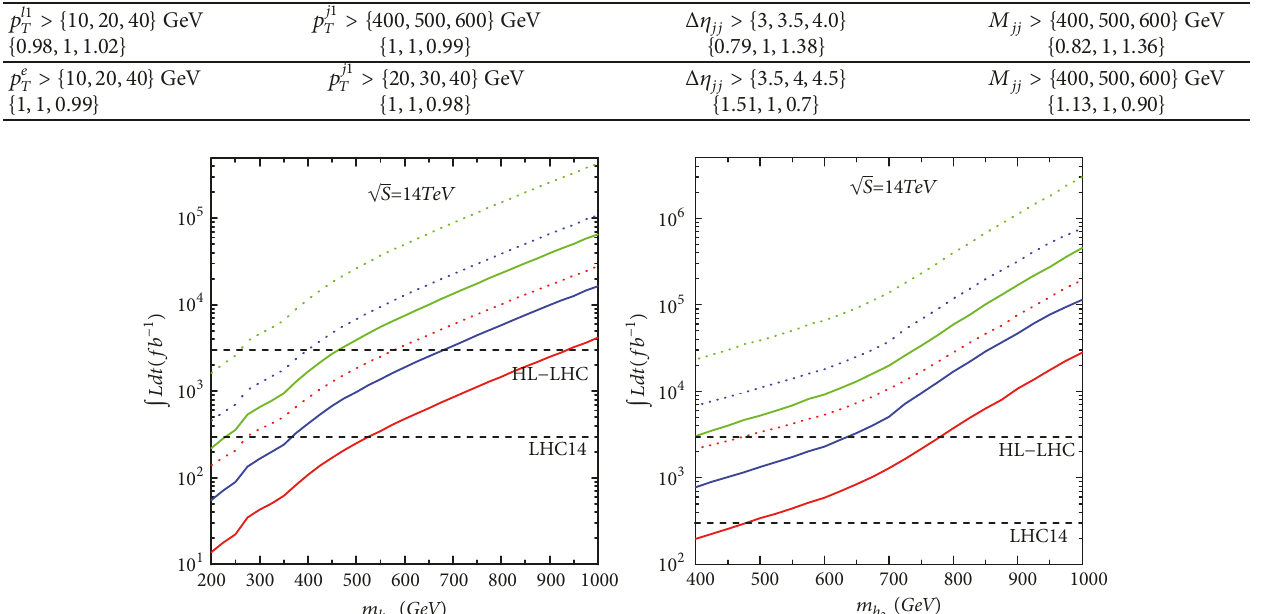
Table 1: Effects on the ratio 𝑆/𝐵 due to variations on the cuts in (6) (top) and (8) (bottom) for benchmark mass 𝑚 ℎ2 = 600 GeV at 14 TeV LHC.